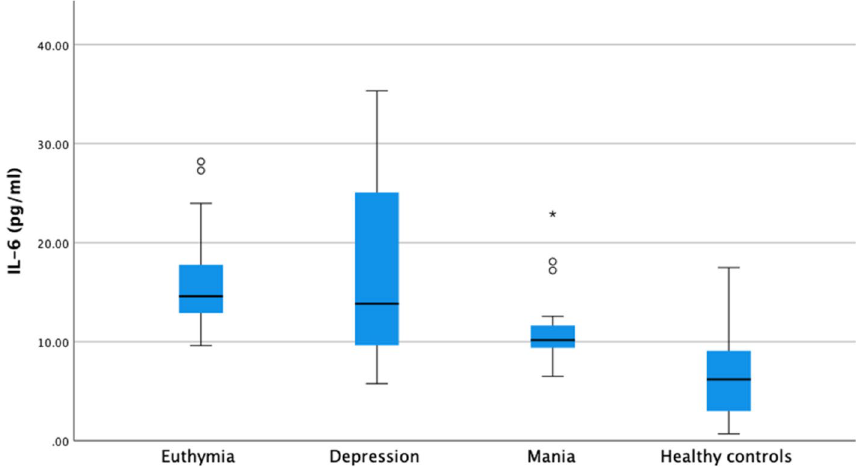
Fig. 1 Boxplot of serum IL-6 levels among studied groups. The pairwise comparison shows that median levels of IL-6 are significantly higher in each BP-I group than in healthy group. Moreover, IL-6 is significantly lower in mania than in euthymia. Also, IL-6 was lower in mania than in depression with statistically significant difference. Circles are mild outliers; asterisks are the extreme outliers